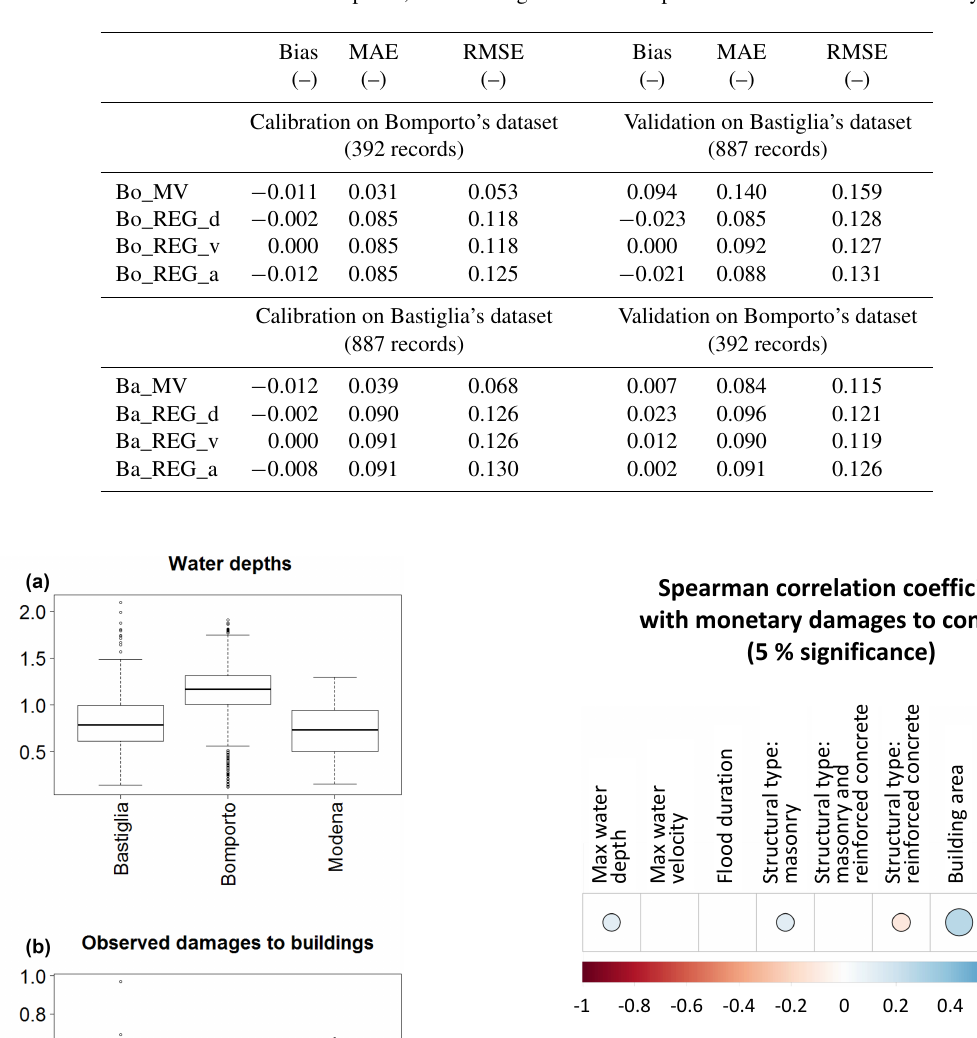
Table 7. Transferability of the models: performance of different uni- and multivariable models in estimating relative damages to buildings in different contexts. In the upper tables, the models were calibrated on Bomporto’s dataset (392 records) and validated in Bastiglia, while in the bottom tables the models were calibrated on Bastiglia’s dataset (887 records) and used to estimate damages in Bomporto. The left tables report performance of the models in the calibration phase, while the right tables show performance of the validation study.